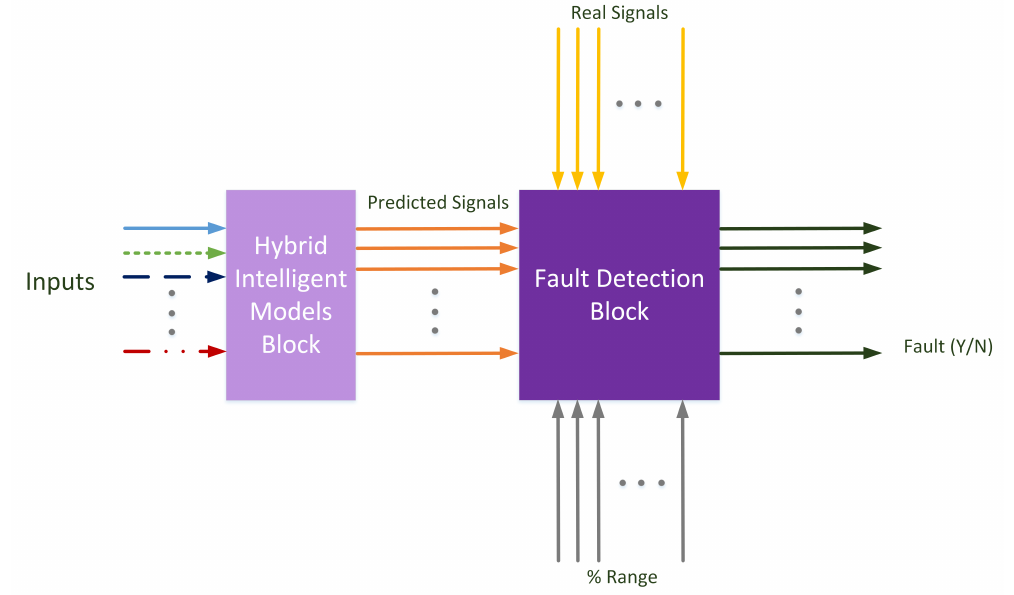
Figure 3. Hybrid model proposal.